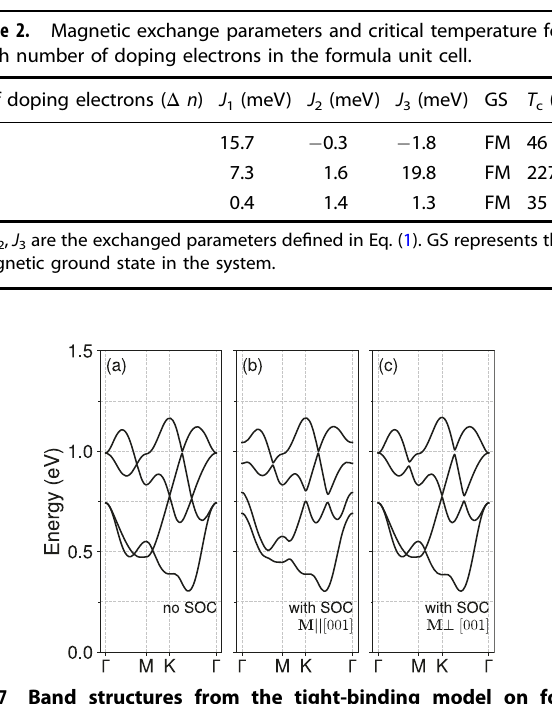
Fig. 7 Band structures from the tight-binding model on four conduction bands above the Fermi level. a Without SOC effect b with SOC effect and magnetization along [001] direction, and c with SOC effect and magnetization direction along [100] direction.